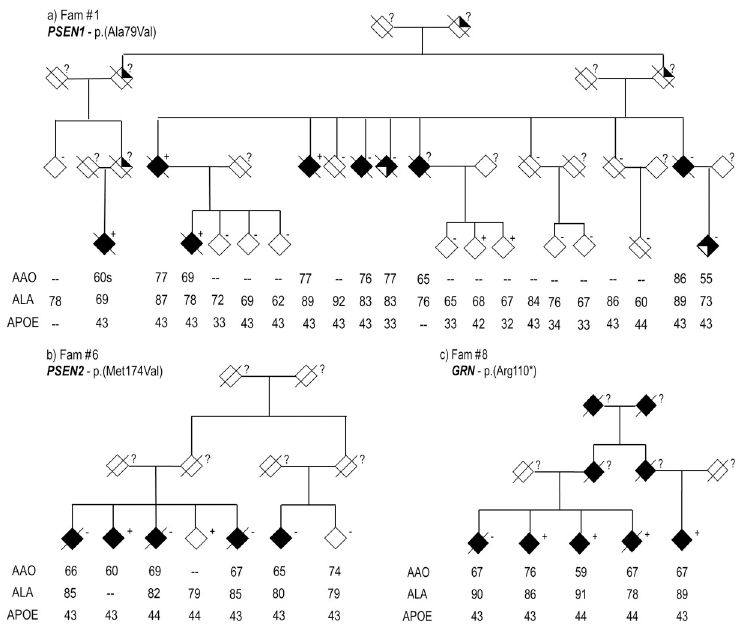
Fig 1. Pedigree structure of families’ carriersof genetic variants. (a) PSEN1 p.(Ala79Val), (b) PSEN2 p. (Met174Val), (c) GRN p.(Arg110 * ). Age at onset (AAO), age at last assessement (ALA) and APOE status is provided for each genotyped